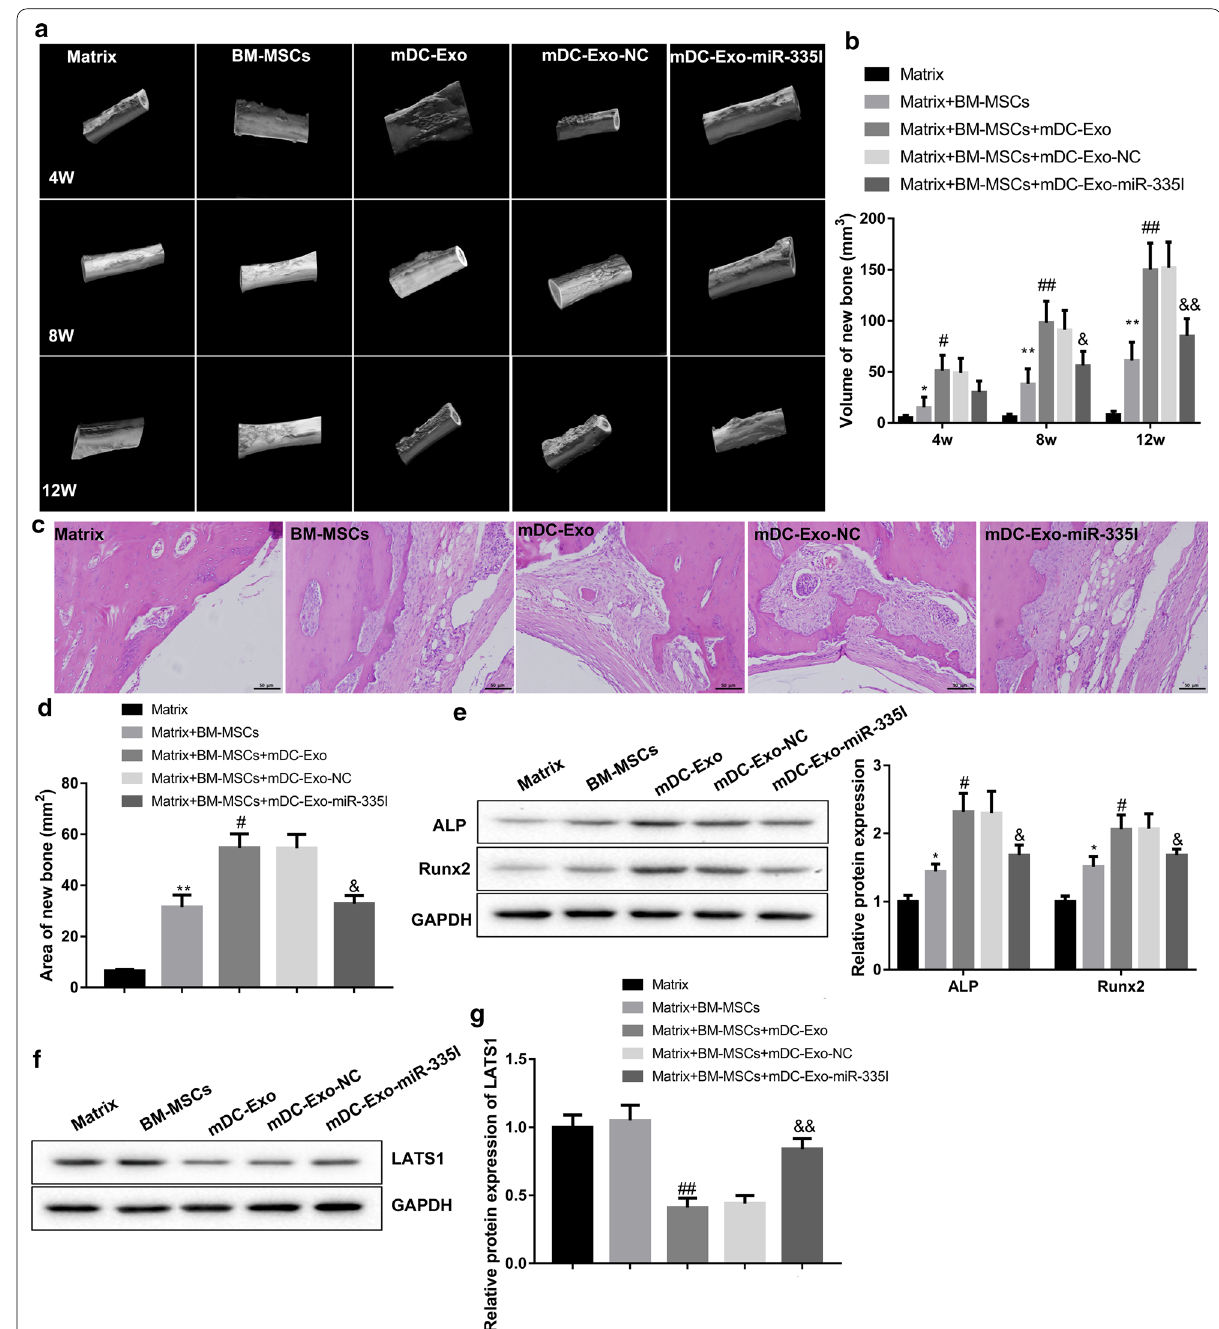
Fig. 5 mDC-Exo enhanced BM-MSCs-mediated bone regeneration by transferring miR-335. Rats were randomly divided into five groups: Matrix, Matrix BM-MSCs, Matrix BM-MSCs mDC-Exo, Matrix BM-MSCs mDC-Exo-NC, and Matrix BM-MSCs mDC-Exo-miR-335I. a Bone + + + + + + + regeneration was monitored via micro-CT scanning at 4, 8 and 12 weeks post-surgery. b Quantification of new bone volume from micro-CT scanning. c Representative H&E staining showing bone defect repair of posterior limbs of rats. d Quantification of new bone area from H&E staining. The protein levels of e ALP, Runx2, and f , g LAST1 in the bone examined by western blot. *P < 0.05, **P < 0.01, vs. Matrix; # P < 0.05, ## P < 0.01, vs. Matrix BM-MSCs; $ P < 0.05, $$ P < 0.01, vs. Matrix BM-MSCs + + +